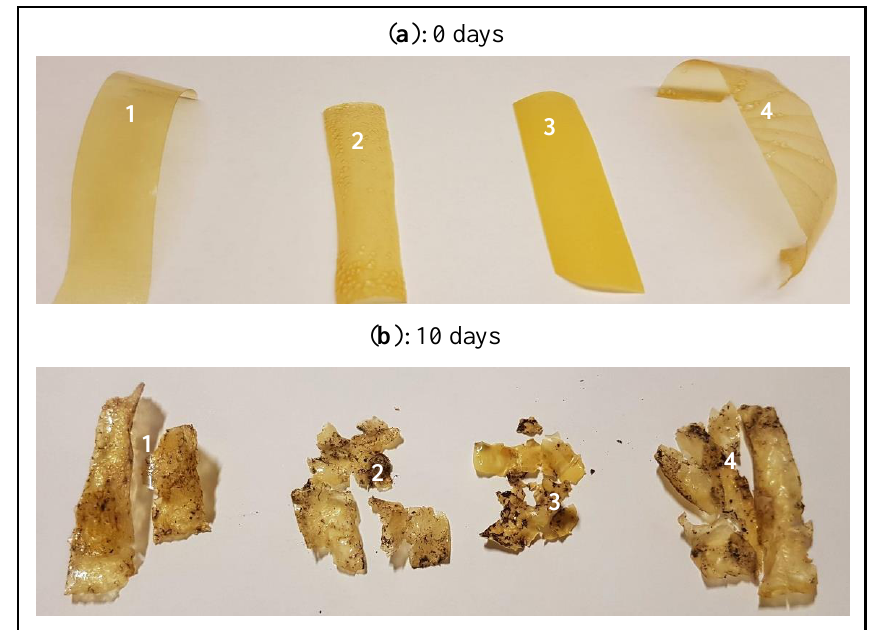
Figure 5. Biodegradability: soil burial degradation test of the films. Film without EO — polystyrene Petri dishes (1), film without EO — lotus negative template (2), film with EO — polystyrene Petri dishes (3), and film with EO — lotus negative template (4); initial films at 0 days ( a ), and films after soil burial degradation test (10 days) ( b ).